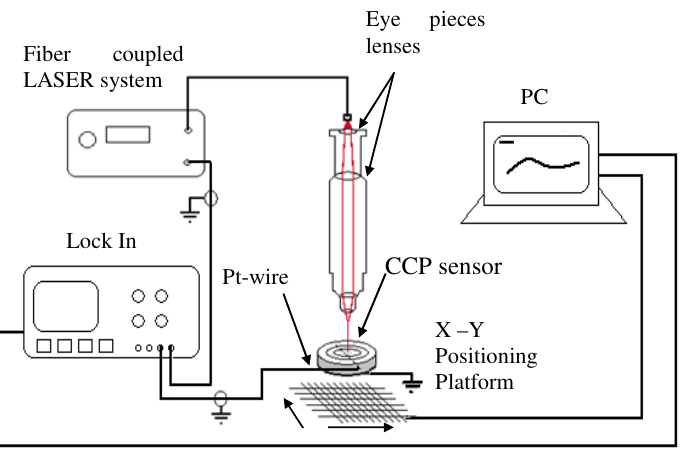
Figure 7. Optical setup to get the sensibility on the selected CCP